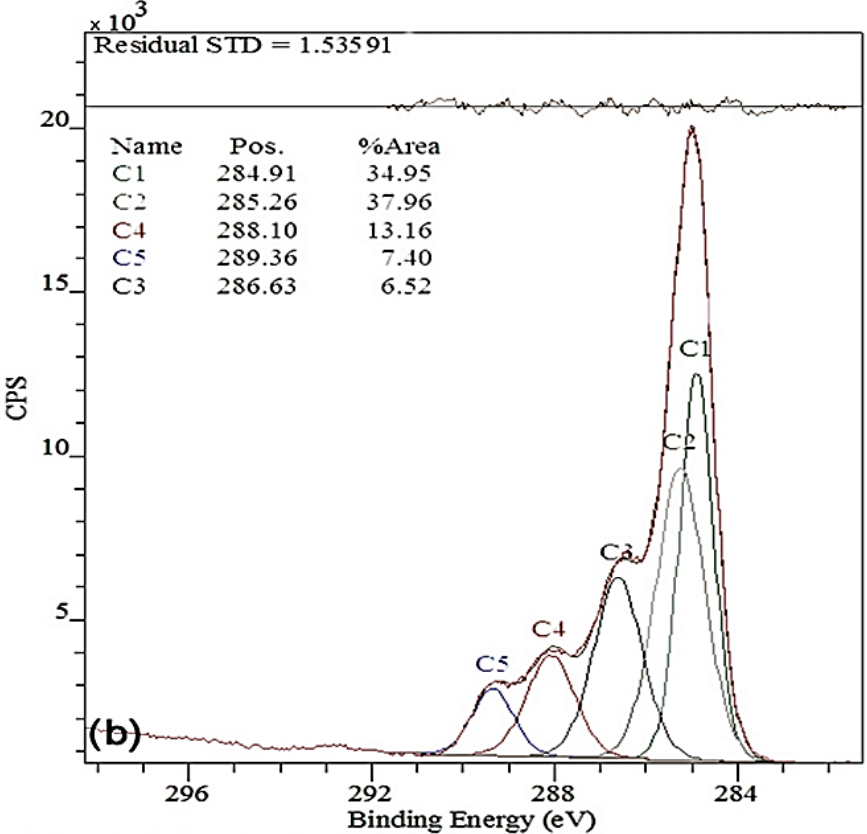
Figure 2. ( a ) XPS wide-scan spectrum; ( b ) C1(S) spectra of CS-g-PLA copolymers.